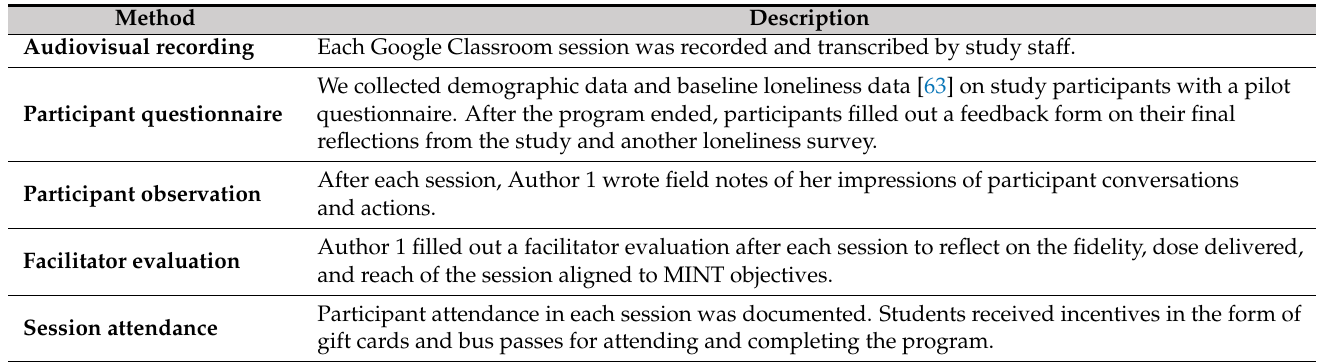
Table 2. Data Collection Methods.